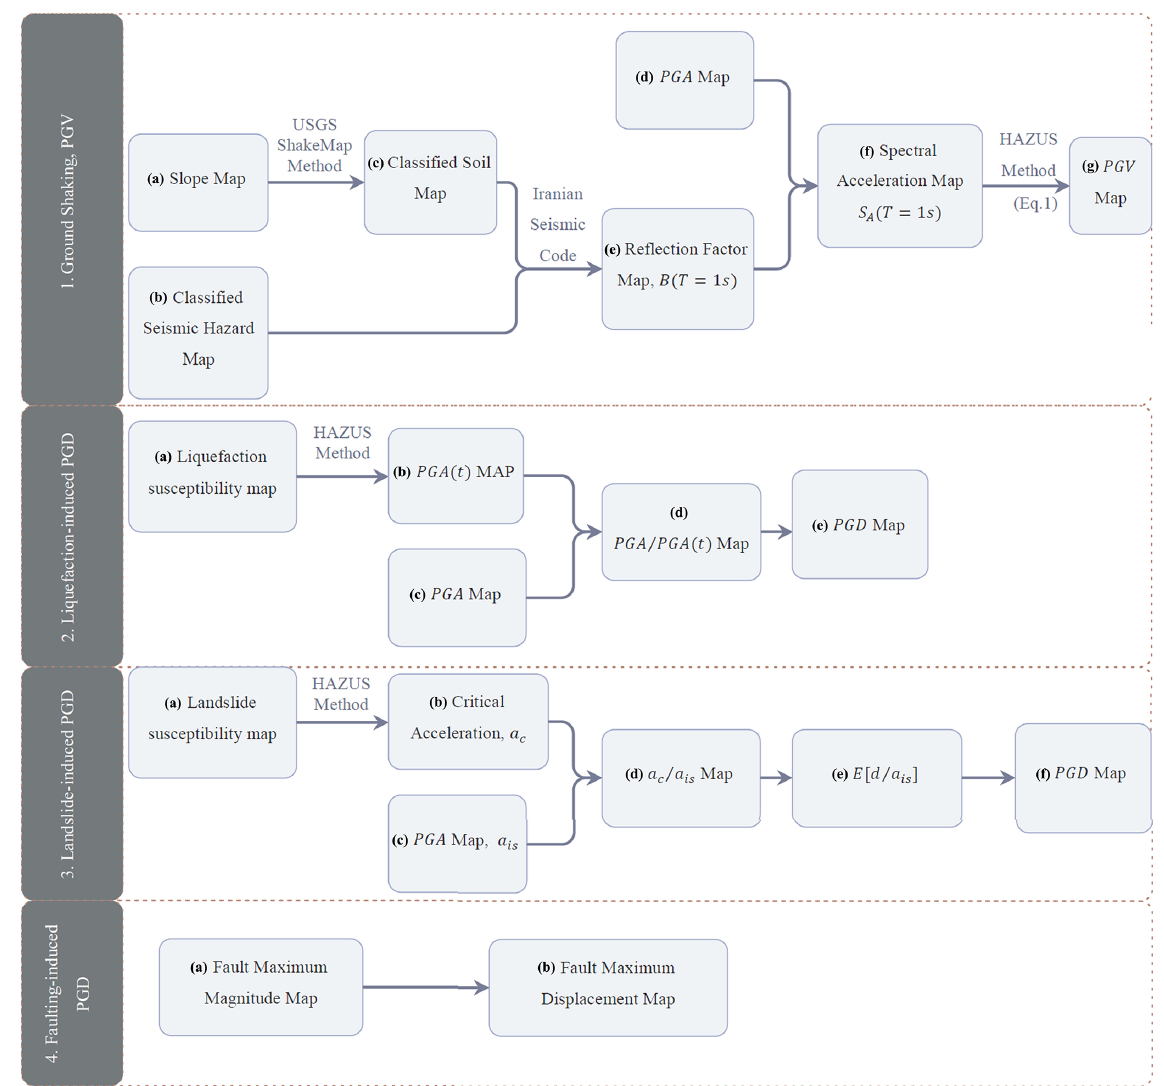
Figure 2. A flowchart for production of PGV and PGD